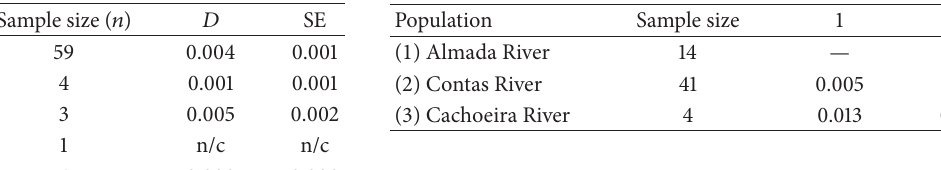
Table 4: Interpopulation genetic distance in COI sequences of Lignobrycon myersi based on K2P